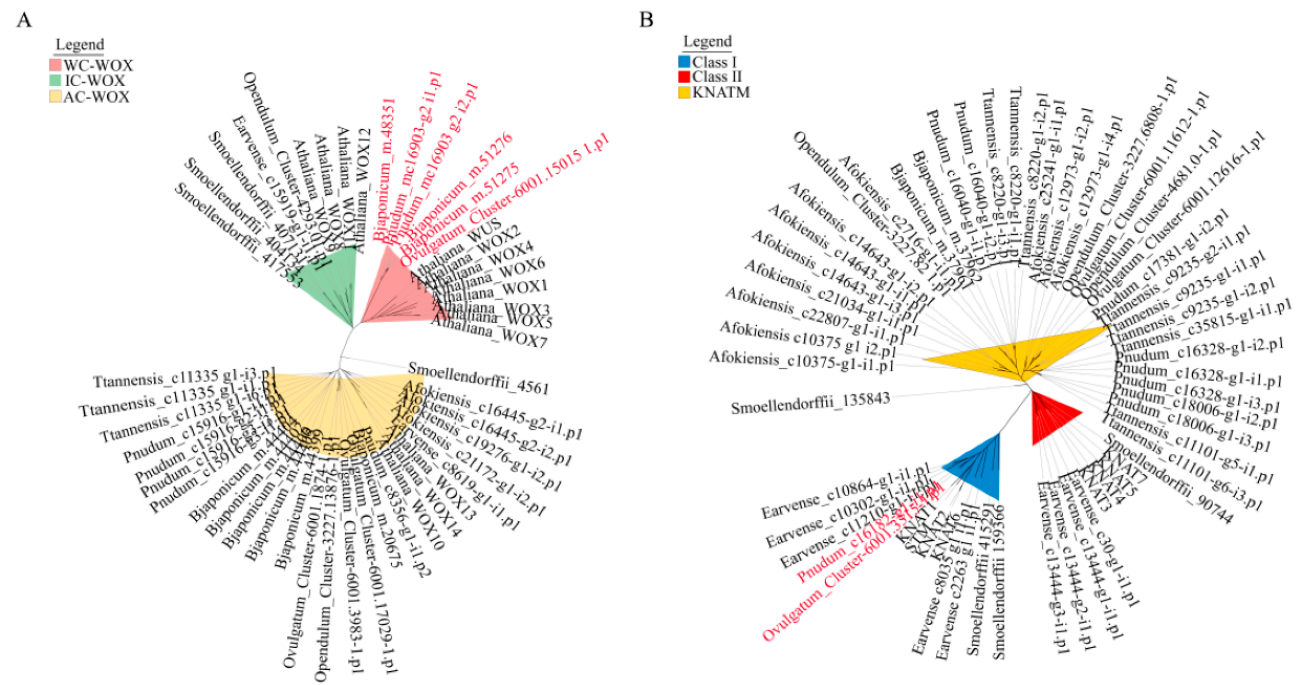
Figure 4. Grouping of WOX and KNOX homologs using the neighbor-joining method. ( A ) A collec- tion of 50 WOX proteins from 9 distinctive plant species. The WC-WOX sequences of whisk ferns and ophioglossoid ferns are highlighted. ( B ) A collection of 58 KNOX proteins from 9 distinctive plant species. The class I sequences of whisk ferns and ophioglossoid ferns are highlighted.